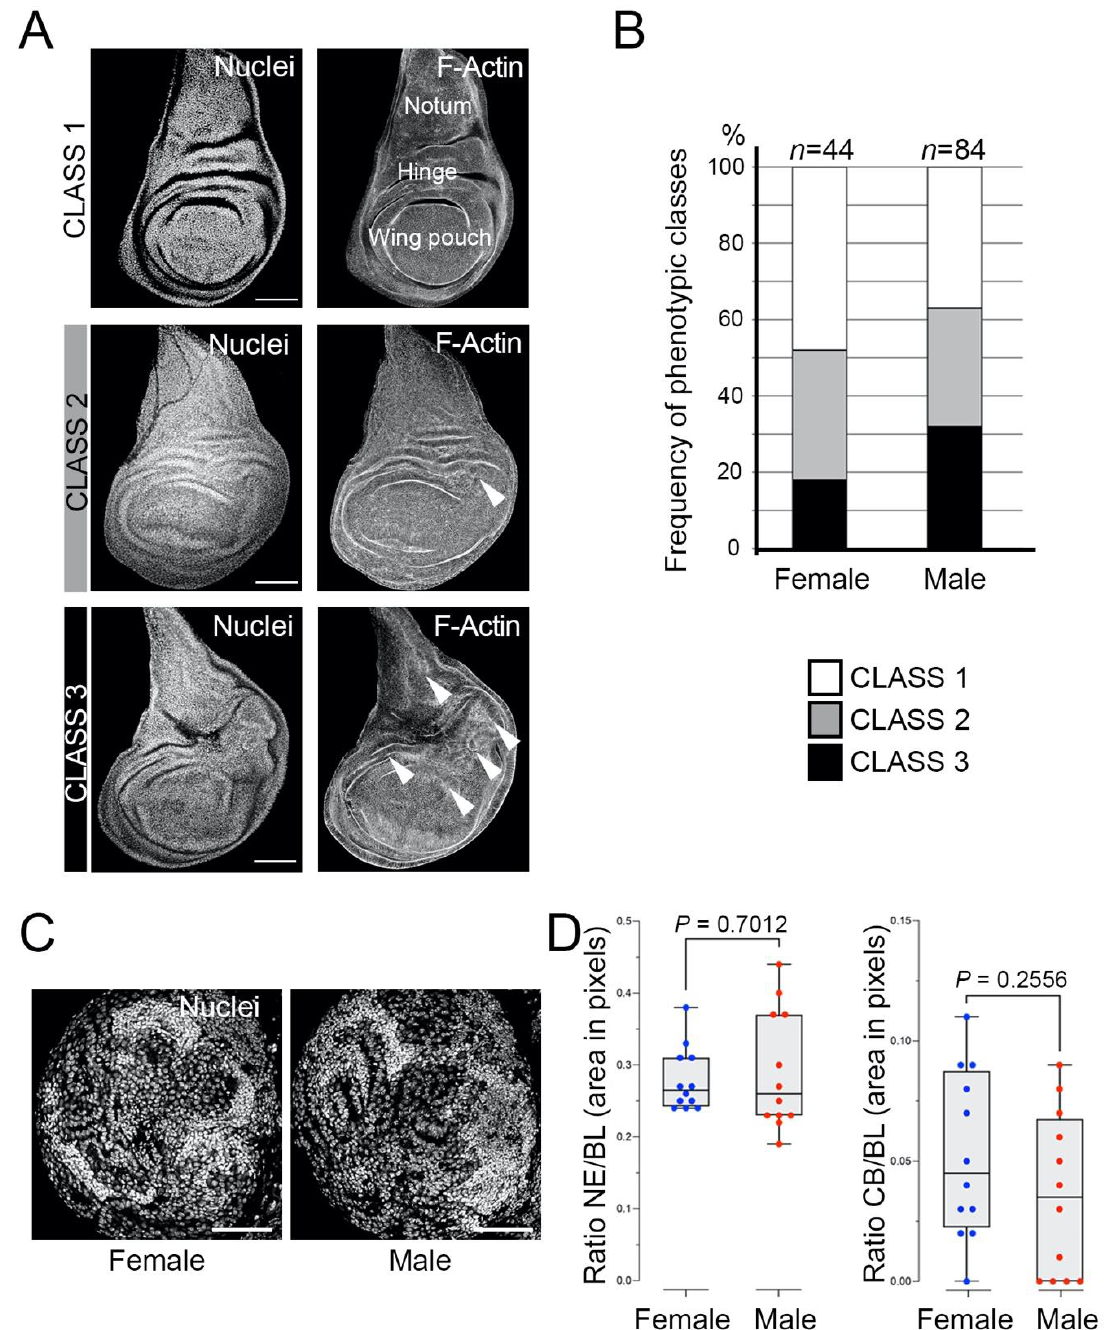
Figure 1. mbt-RNAi mutants produce overgrowth in wing imaginal discs and brains. ( A ) Wing discs from mbt-RNAi mutant larvae stained with TO-PRO3 (Nuclei) and Phalloidin (F-actin), showing the three phenotypic classes: (1) absence of overgrowth; (2) mild and few overgrowths; (3) strong and multiple overgrowths. Arrowheads point to anomalous folding resulting from multiple overgrowths. The three main regions of the disc (wing pouch, hinge, and notum) are indicated. Scale bars: 50 µ m. ( B ) Incidence of the overgrowth phenotypes in female and male mbt-RNAi wing discs. ( C ) Larval brain lobes from female and male mbt-RNAi larvae stained with DAPI (Nuclei). Female and male brain lobes present reduced central brains (CBs) and overgrown neuroepithelia (NE). Scale bars: 50 µ m. ( D ) Relative sizes of NE and CB (as a fraction of brain lobe (BL) area) in female (blue) and male (red) mbt-RNAi mutant larvae. No significant differences are observed in NE and CB sizes between mbt female and male brain lobes.